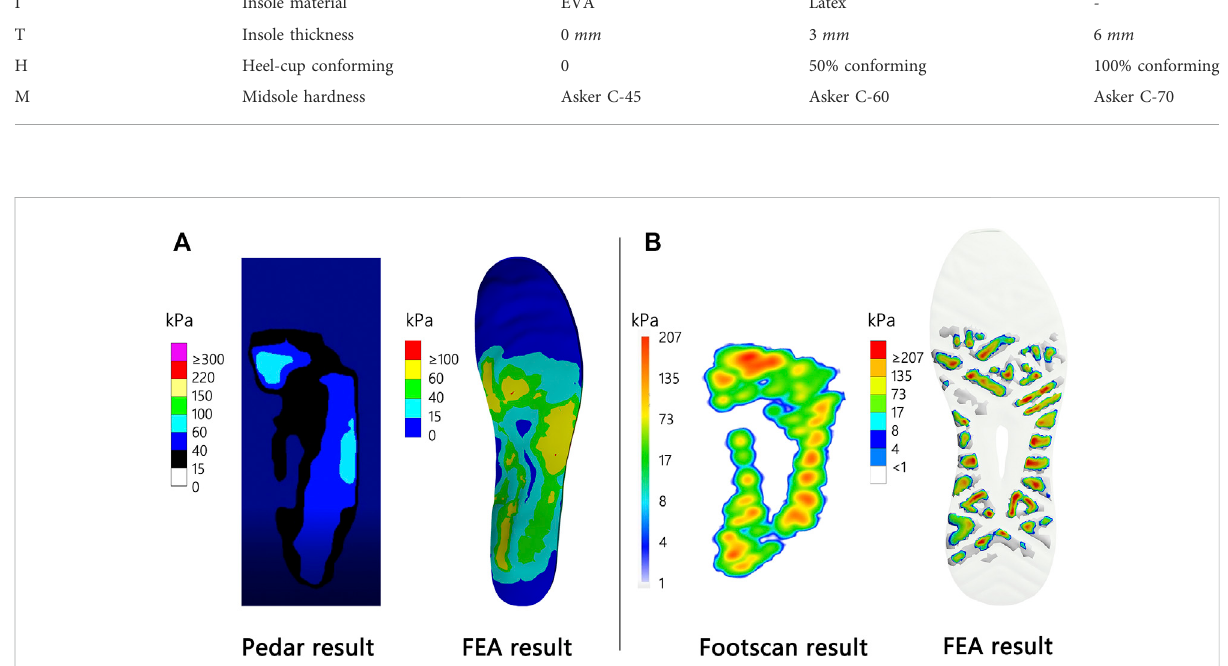
FIGURE 3 Measured and FE analyzed results of (A) insole and (B) outsole